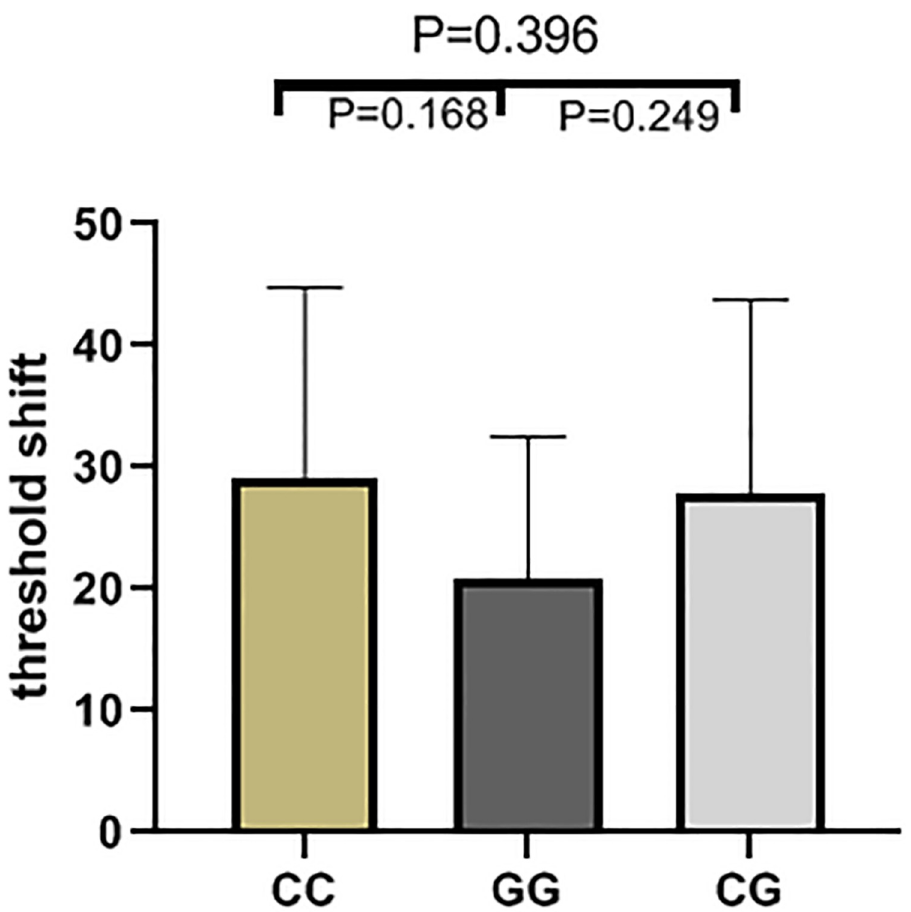
Fig 1. The genotypic distributions of rs2744434. The height of each column is the value of hearing threshold and each column stands for 1 genotype.